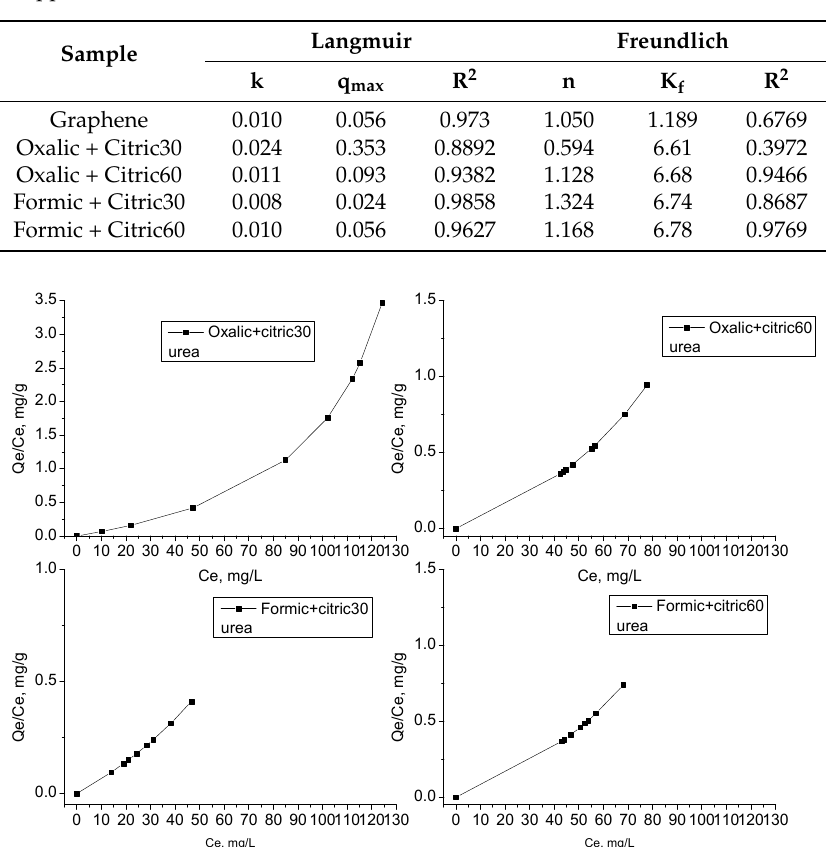
Figure 10. Percentage removal of uric acid using graphene and modified graphene with organic acids and ultrasonic radiation. Table 3. Parameters of isotherms for urea adsorption, according with the Langmuir and Freundlich approach.